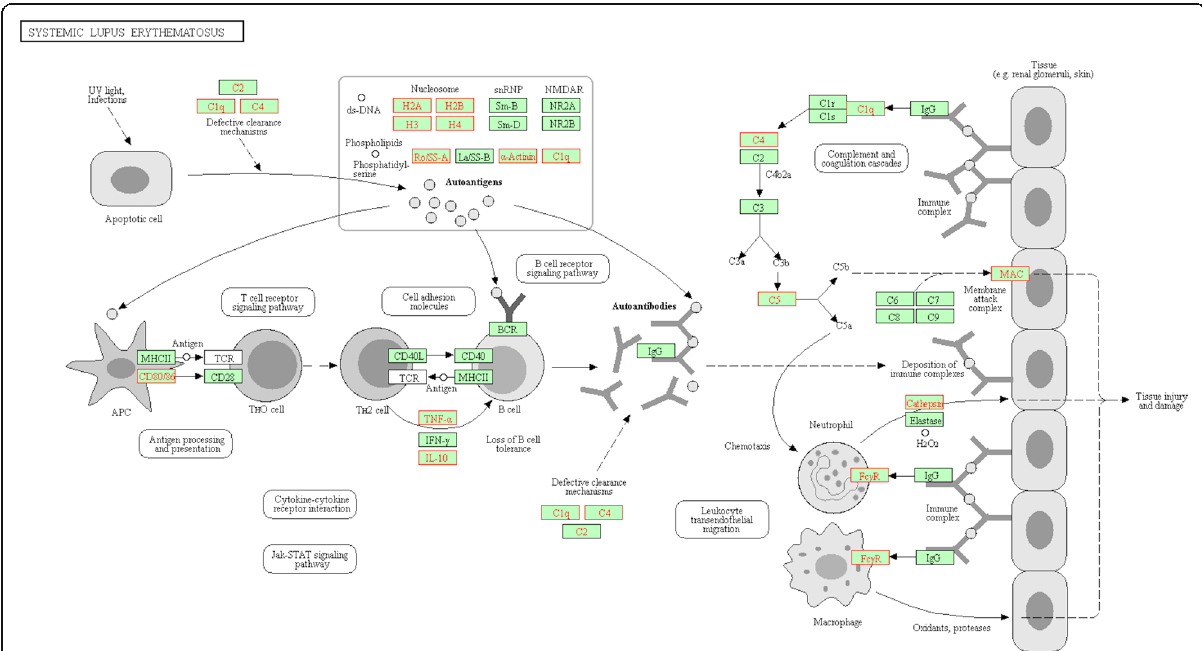
Fig. 6 Systemic lupus erythematosus pathway in KEGG. The core enrichment genes identified in GSEA are shown in red